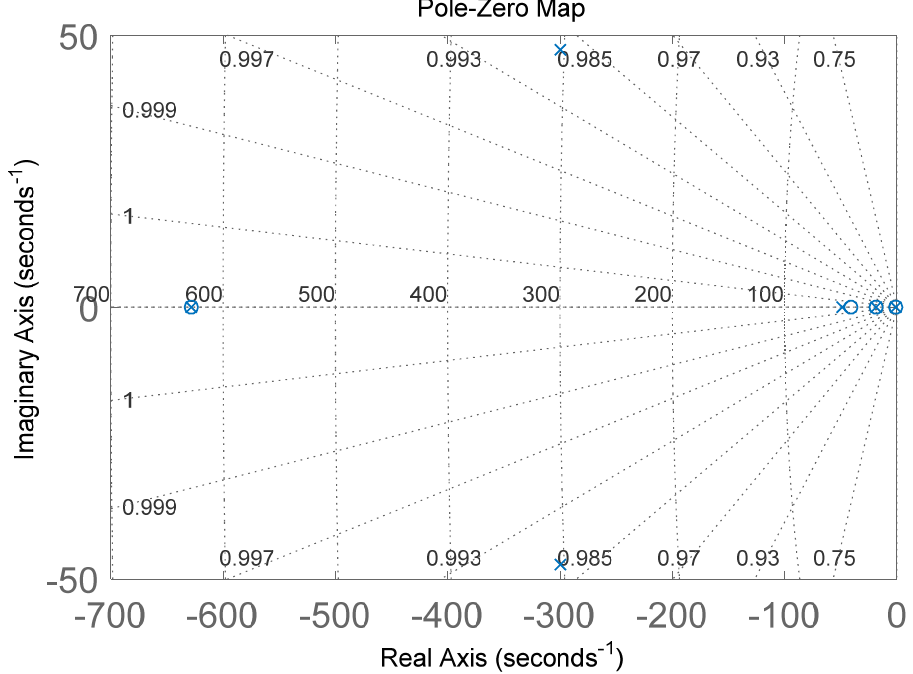
Figure 4. Schematic diagram of the zero pole of the drive loop.